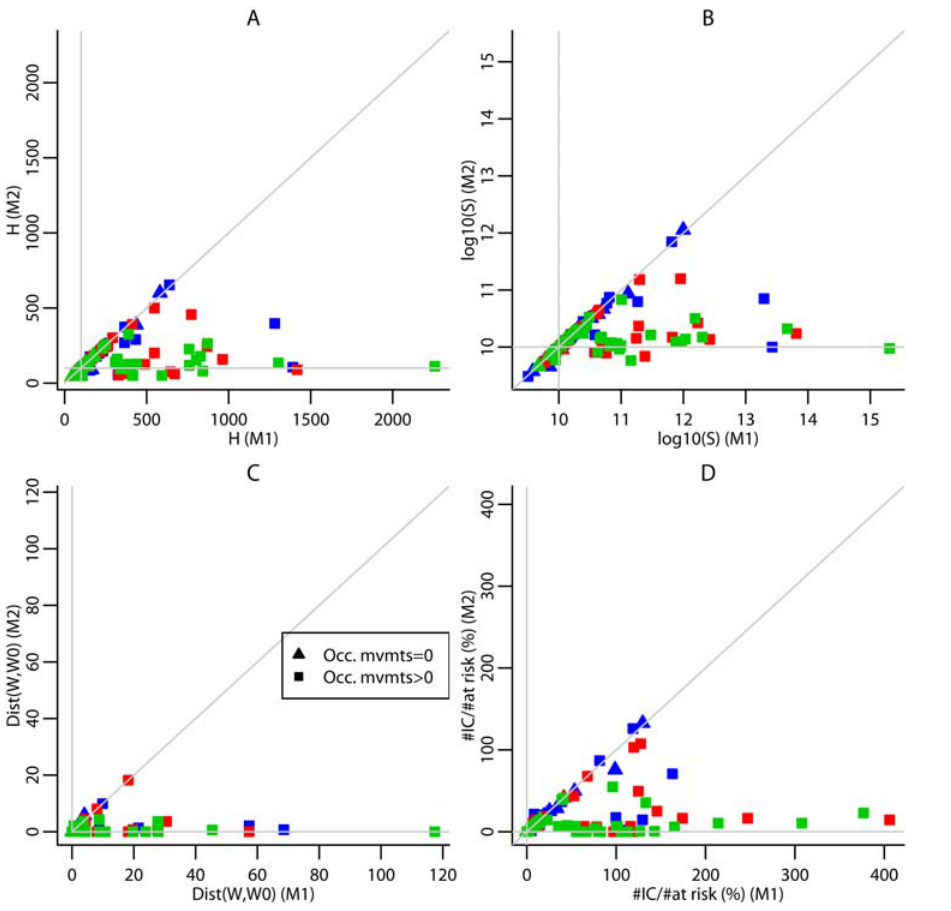
Figure 3. Comparison of the estimates based on the standard model (M1) with estimates based on the model allowing for occasional movements during the day (M2). Estimates of the height (A), strength (B) and location (C) of the source for outbreaks simulated with Scenario E, based on the first 5 (blue), 10 (red), 15 (green) observed cases. (D) Ratio of the number of individuals inaccurately targeted (IC) by the mitigation strategy for a risk threshold of 1/100,000 relative to the theoretical number of individuals at risk (%). Triangles indicate estimates for simulations in which there is no observed case infected during an occasional movement. Rectangles indicate estimates for simulations in which there is at least one observed case infected during an occasional movement. The horizontal and vertical lines indicate the true values. The third line is the bisector.